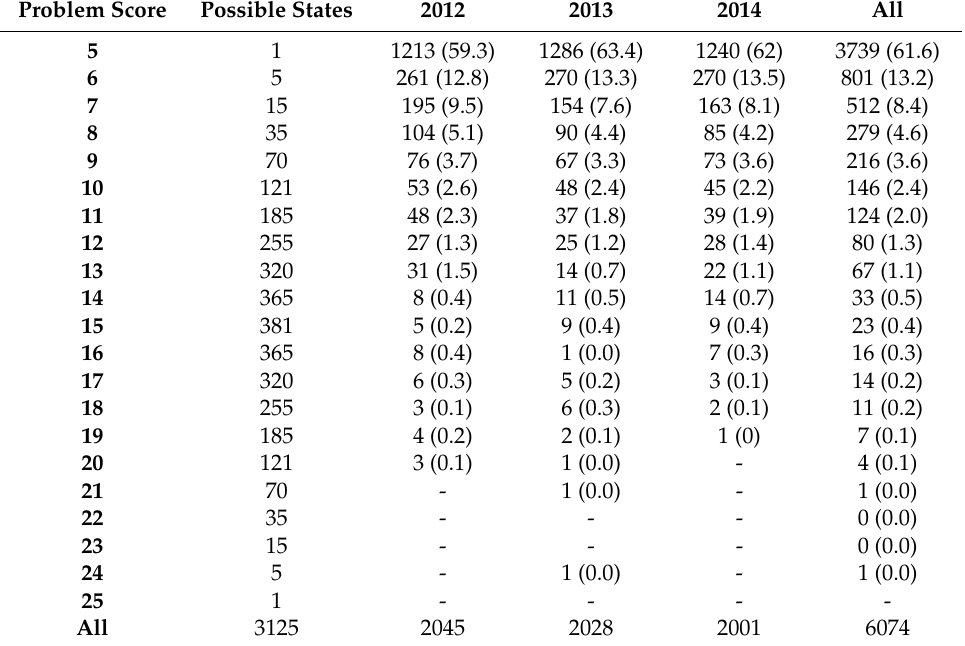
Table 3. Problem score